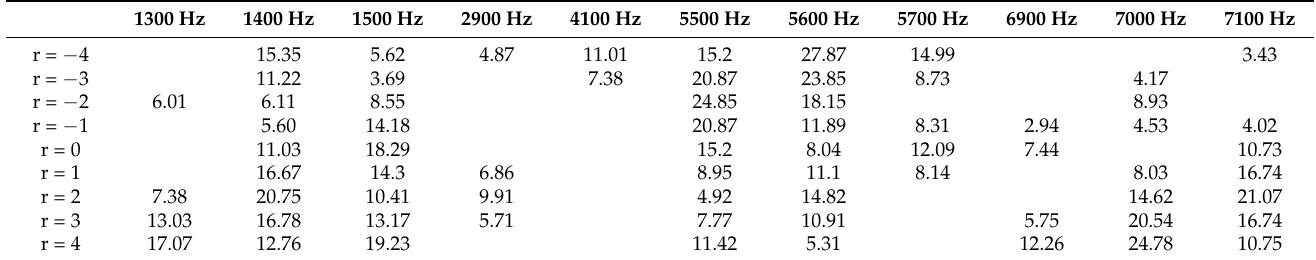
Table A2. Frequency, order and amplitude of electromagnetic force wave under 30% static eccentricity operating conditions.